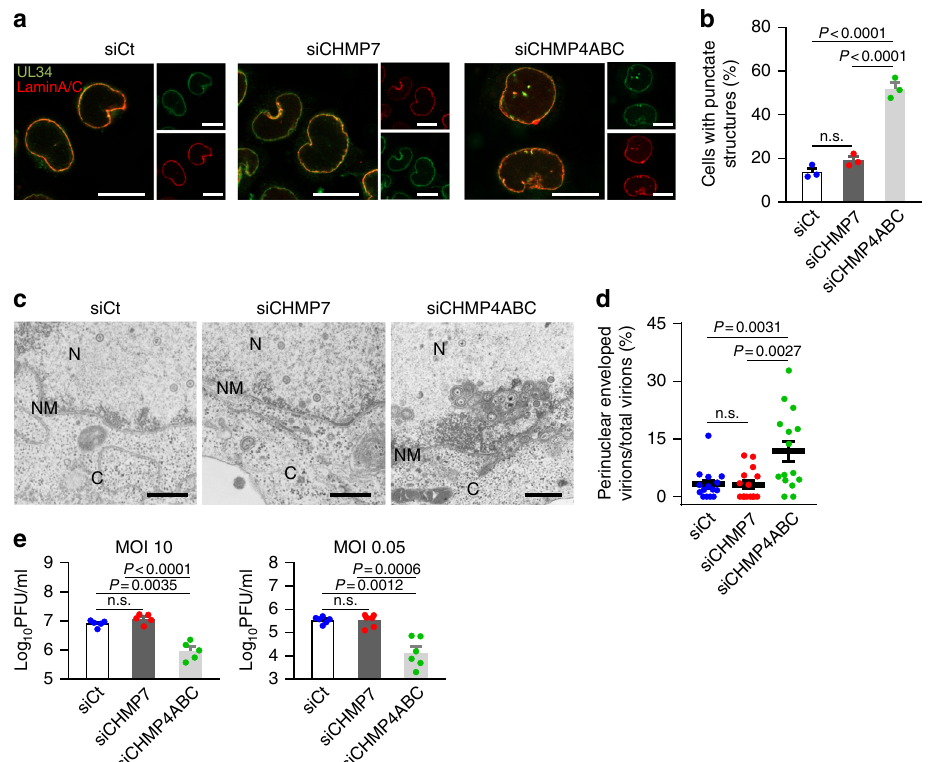
Fig. 6 Effects of CHMP7 depletion on HSV-1 replication. a Confocal microscope images of HeLa cells treated with control siRNA (siCt), siRNA to CHMP7 (siCHMP7), or siRNA to CHMP4A, B, and C (siCHMP4ABC) for 48 h and infected with HSV-1 for 22 h. Images are representative of three independent experiments. Bars, 20 μ m. b The percent of cells (100 – 200 cells in each experiment) with aberrant punctate structures along with the nuclear rim was determined in the experiment in ( a ). Data are shown as the mean ± SEM of three independent experiments. c Electron microscope images of HeLa cells treated with siRNA as described in a and infected with HSV-1 for 22 h. C cytoplasm, N nucleus, NM nuclear membrane. Bars, 500 nm. Images are representative of three independent experiments. d The percent of perinuclear enveloped virions in 15 cells in the experiment in ( c ) was determined. Data are shown as the mean ± SEM and are representative of three independent experiments. e HeLa cells treated with siRNA as described in ( a ) were infected with HSV-1 at an MOI of 10 or 0.05 and viral titers were assayed at the indicated times post infection. Data are shown as the mean ± SEM of fi ve (MOI 10) or six independent experiments (MOI 0.05). The indicated P -values were obtained using the Tukey ’ s test ( b , d , e ). n.s., not signi fi